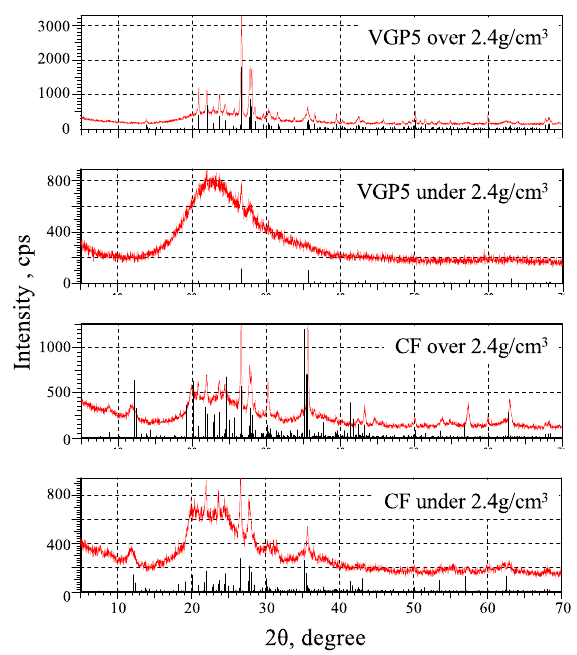
Figure 6. XRD of VGP and CF. Table 3. Results of Rietveld